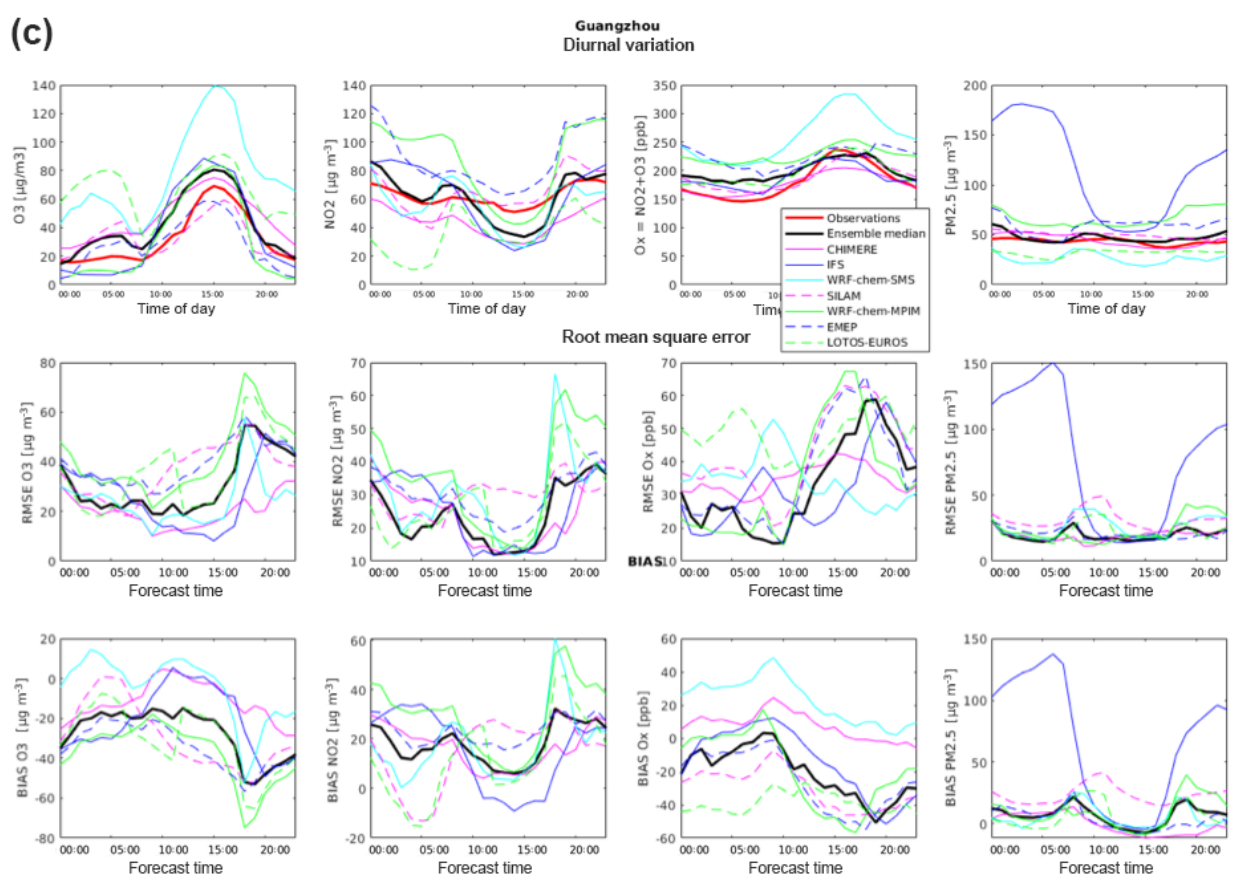
Figure 11. (a) Same as Fig. 10 but for the urban area of Beijing. The statistical variables for PM 2 . 5 are also included. (b) Same as Fig. 10 but for the urban area of Shanghai. The statistical variables for PM 2 . 5 are also included. (c) Same as Fig. 10 but for the urban area of Guangzhou. The statistical variables for PM 2 . 5 are also included.